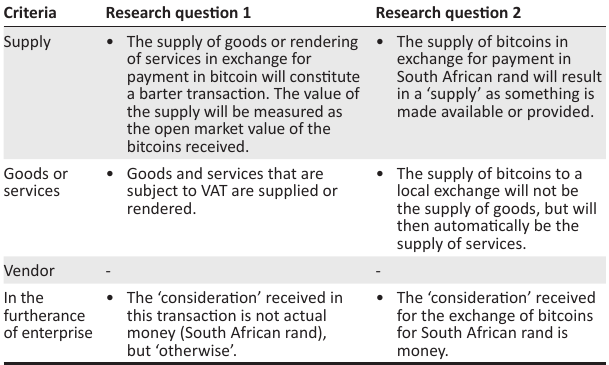
TABLE 2: Determine if research question 2 constitutes a financial service. Financial service (Republic of South Africa 1962:606)